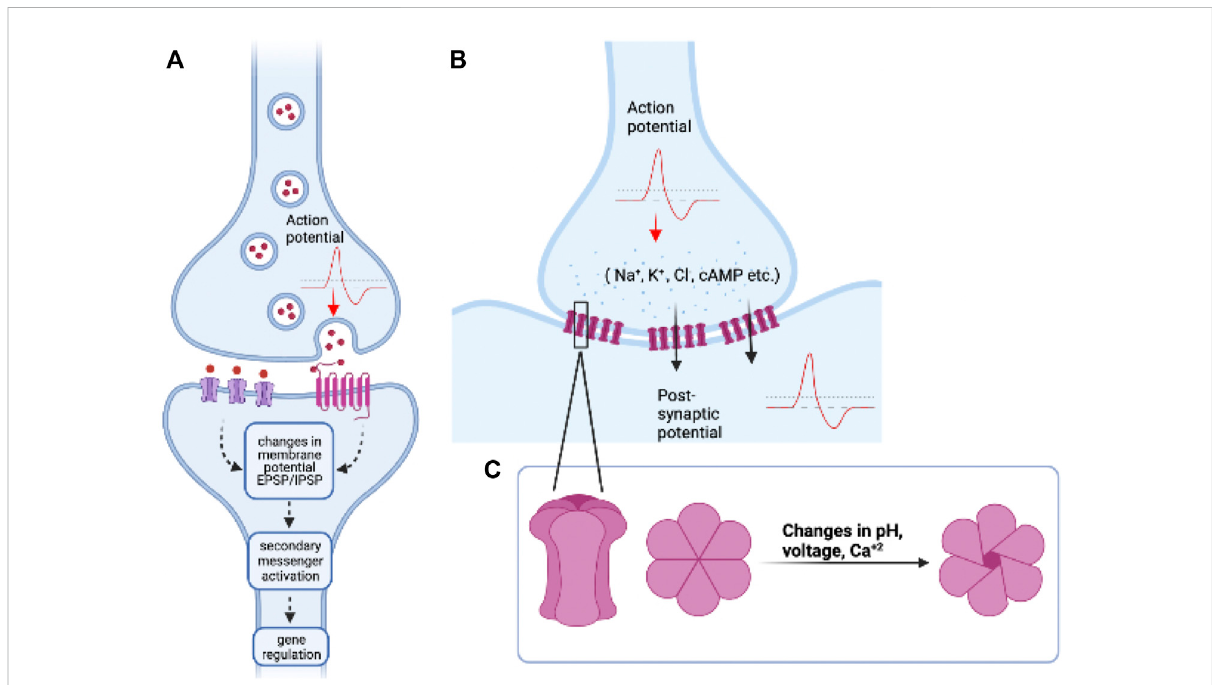
FIGURE 1 An overview ofchemicalandelectrical synapses: (A) Chemicalsynapses work via therelease ofneurotransmittersorneuropeptideswhich bind totheirrespectiveionotropicand/ormetabotropicreceptorsandinitiateacascadeofcellsignallingeventsinthepost-synapticneuron. (B) Electrical synapsesformdirectcell-cellconnections via gapjunctionproteinsmadeupofConnexinsorInnexins.Theactionpotential/sub-thresholdpotential from the pre-synaptic cell, in this case, is directly transferred to the post-synaptic cell by passage of ions or small molecules, such that these cells are “ electrically coupled. ” (C) Inset: (left) Structure ofa gapjunction hemichannel(Connexon) madeup of sixunits of Connexin or proteins. Top viewofConnexoninclosed(middle)andopen(right)con fi gurations.Theopeningandclosingofgapjunctionsisregulatedbyvariousfactorssuchas changes in pH, transmembrane voltage differences, and Ca +2 levels. Image created using